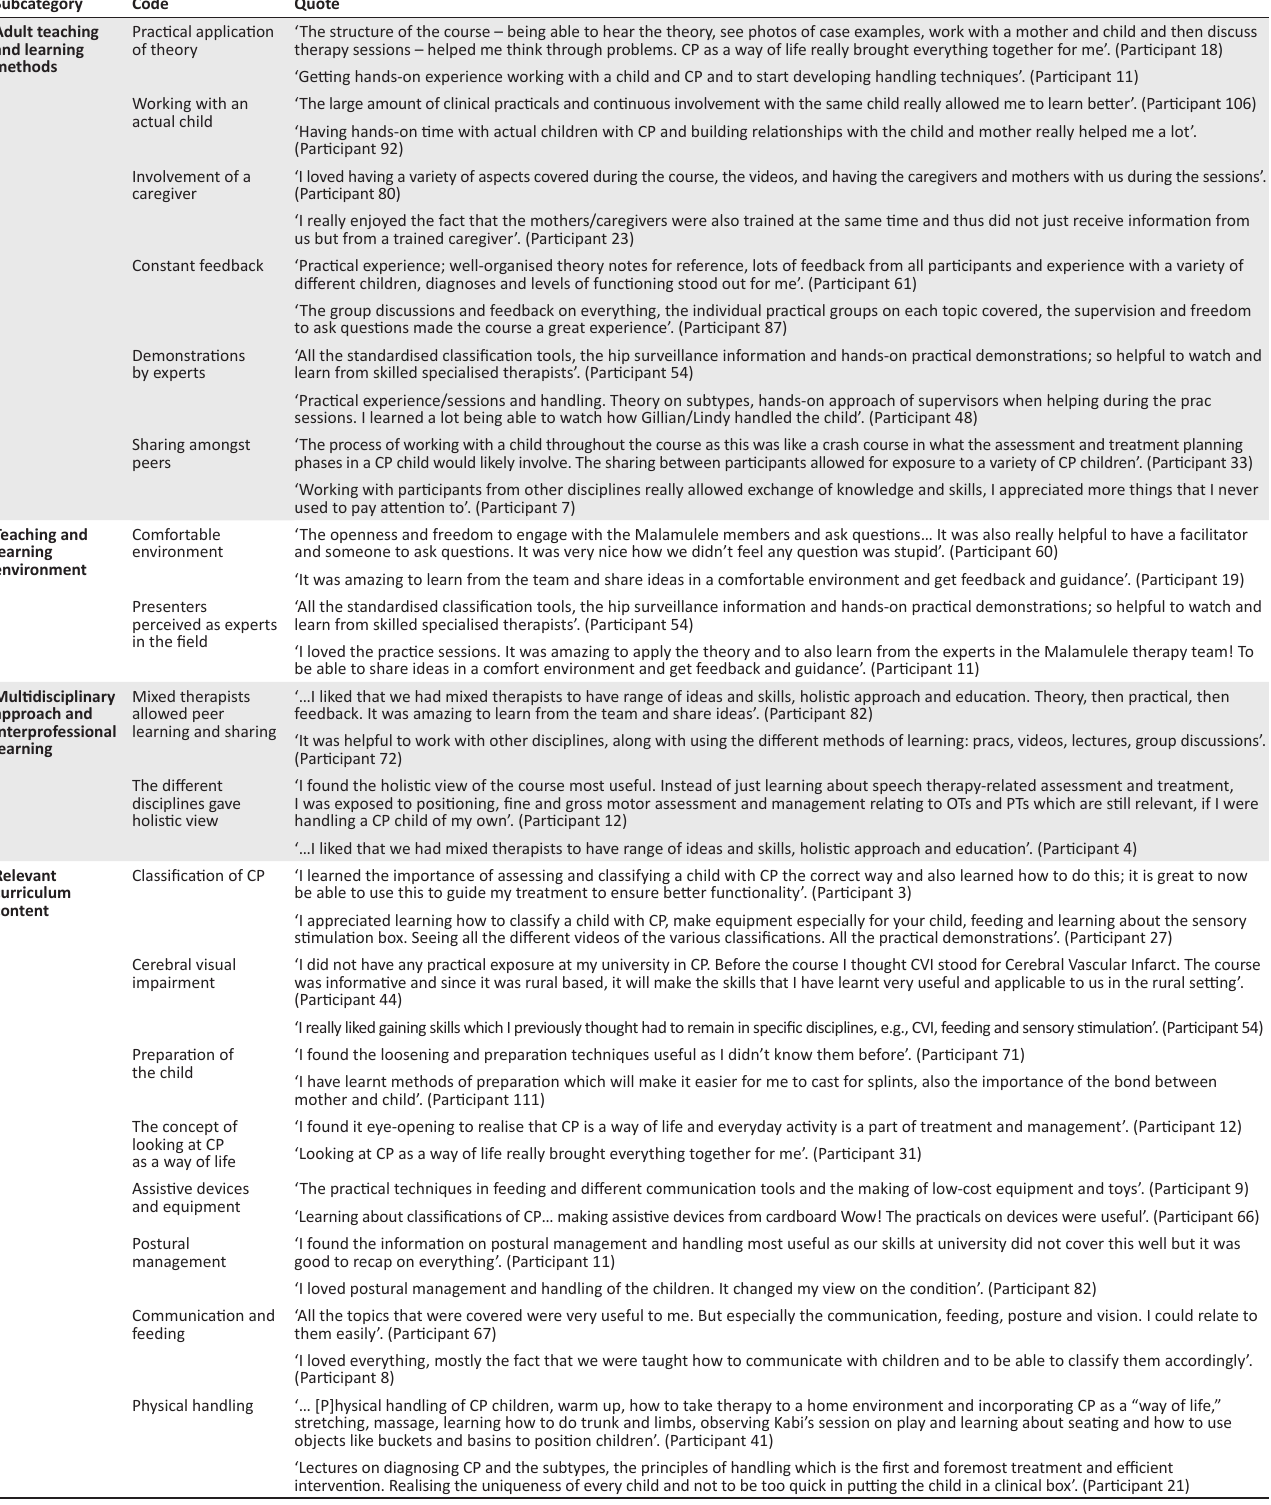
TABLE 6: Elements identified by participants as essential components of the course. Subcategory Code Quote Adult teaching Practical application and learning of methods